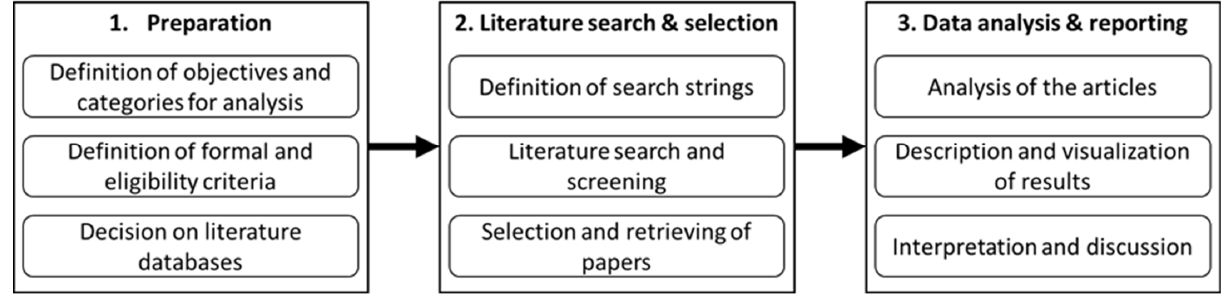
Figure 1. Overarching review process applied in this study (adapted from Verwiebe et al. [135]).